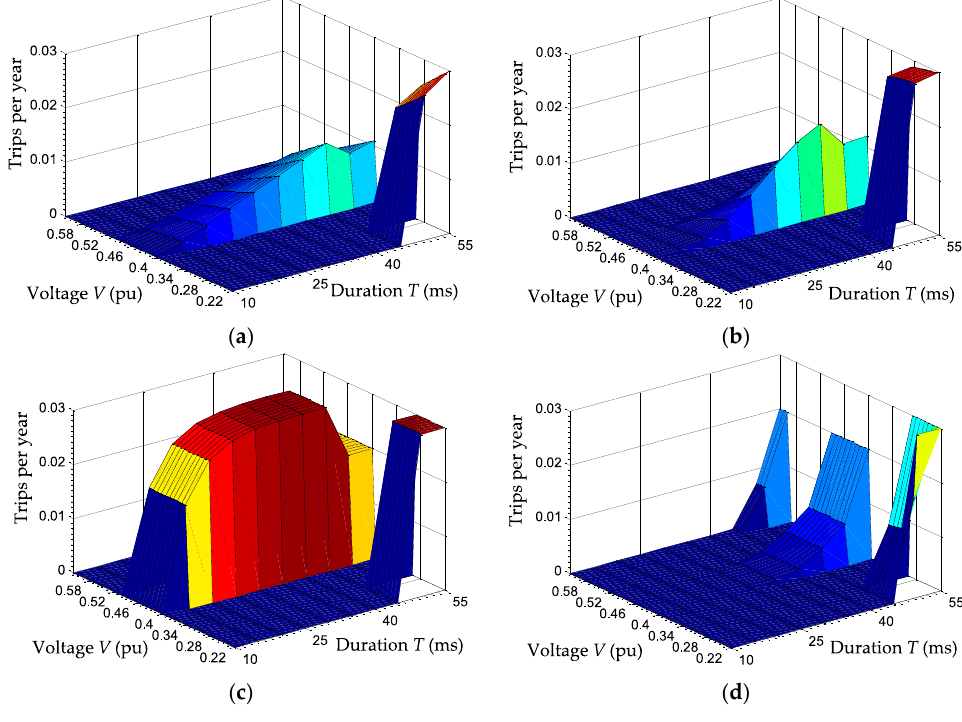
Figure 19. Number of expected trips per year of various voltage–tolerance characteristics for FL: ( a ) uniform; ( b ) normal; ( c ) exponential; and ( d ) reverse exponential.